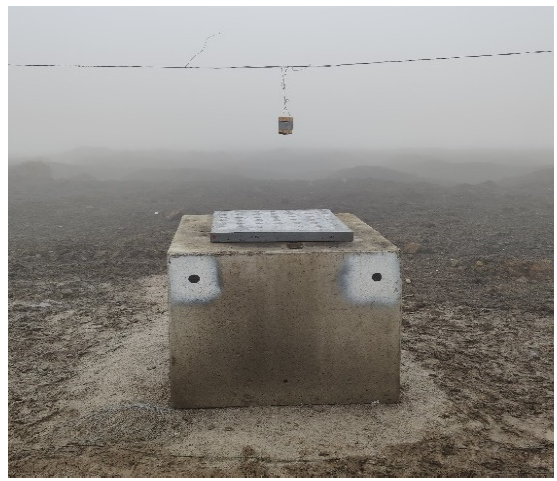
Figure 2. Overview of the experiment–blast loading of the concrete slab.